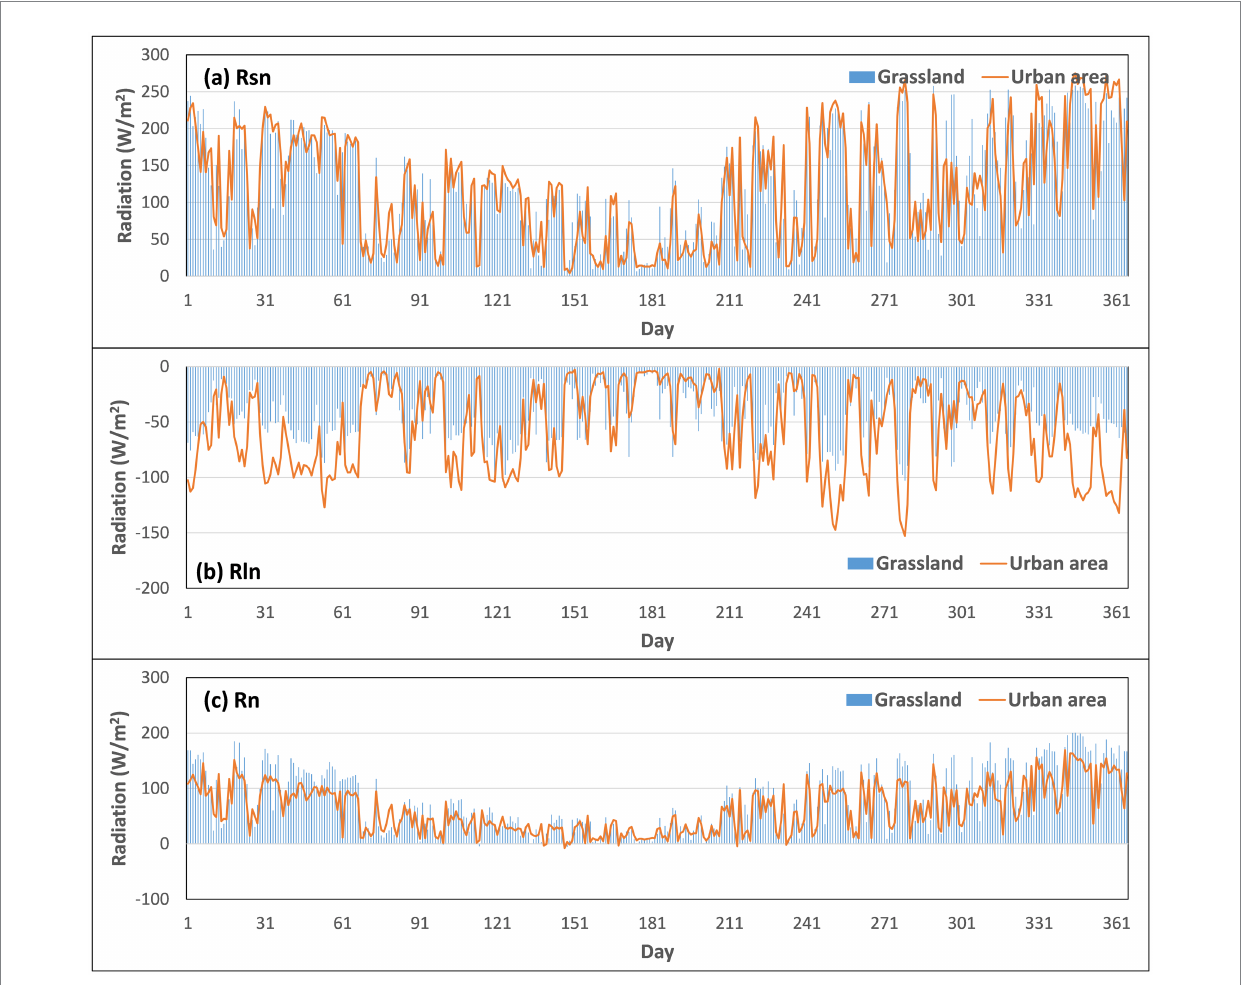
FIGURE 3 Temporal variations of surface radiation of (A) Rsn, (B) Rln, and (C) Rn in grassland and urban areas from Aug 1st in 2021 to July 31st in